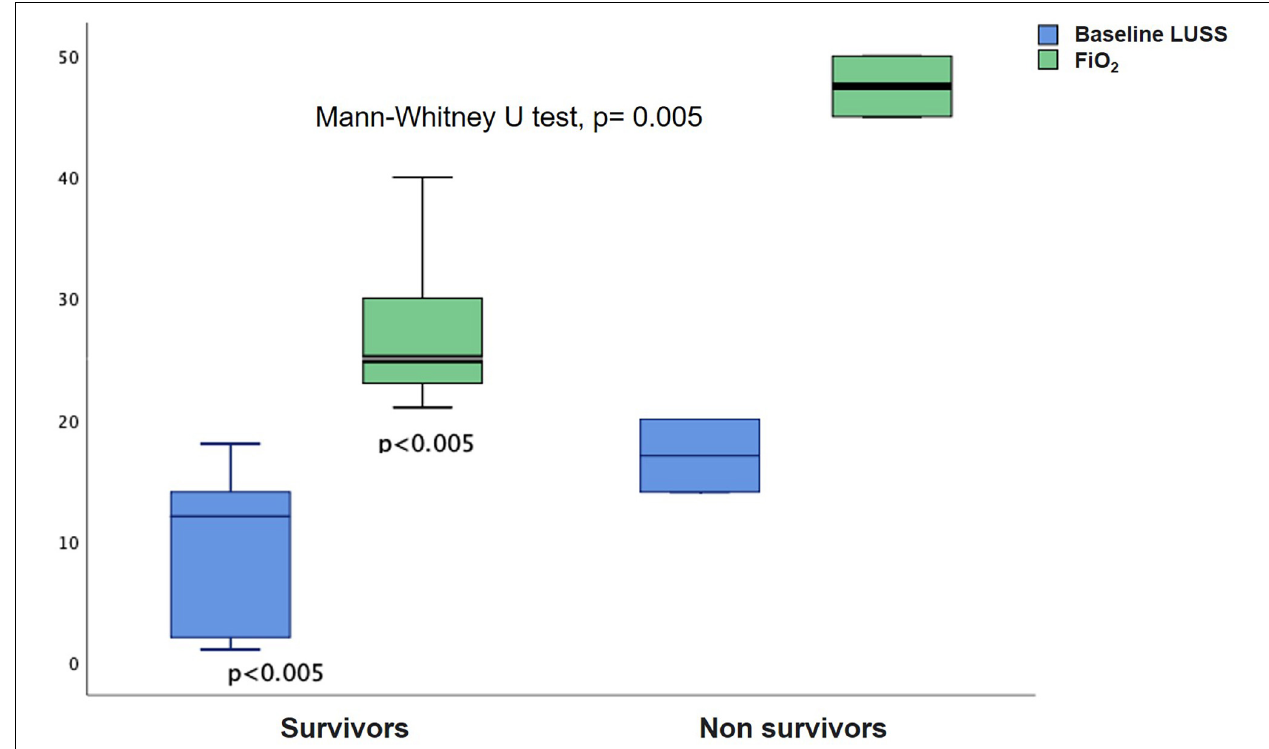
FIGURE 6 | Rank difference between LUSS and FiO 2 needed between survivors and non-survivors (Mann–Whitney U -test, p =